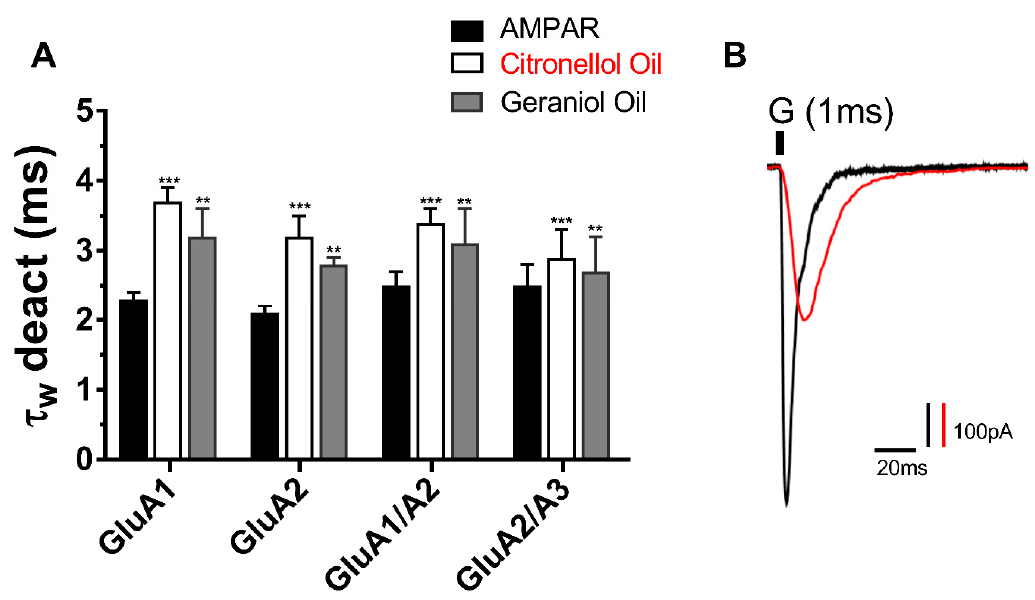
Figure 3. Effect of oils and compounds on AMPAR Deactivation. ( A ). The graphical representation that summarizes the weighted time constants for deactivation ( τ W deact) for the whole cell recordings of all AMPARs subunits, conducted at − 60 mV, pH 7.4, and 22 °C, upon 1 ms application of 10 mM glutamate alone (black), glutamate + Citronellol (white), and from glutamate + Geraniol (grey). ( B ). Pairs of representative whole-cell current traces from GluA1 channels (most significant) expressed in HEK-293 cells in the absence (left) and presence (right) of Citronellol oil. Data shown are mean ± SEM; n = 4 (number of patch cells in the whole-cell configuration). A one-way ANOVA test was used to measure the significance: * p < 0.05; ** p < 0.01; *** p < 0.001; ns, not significant.